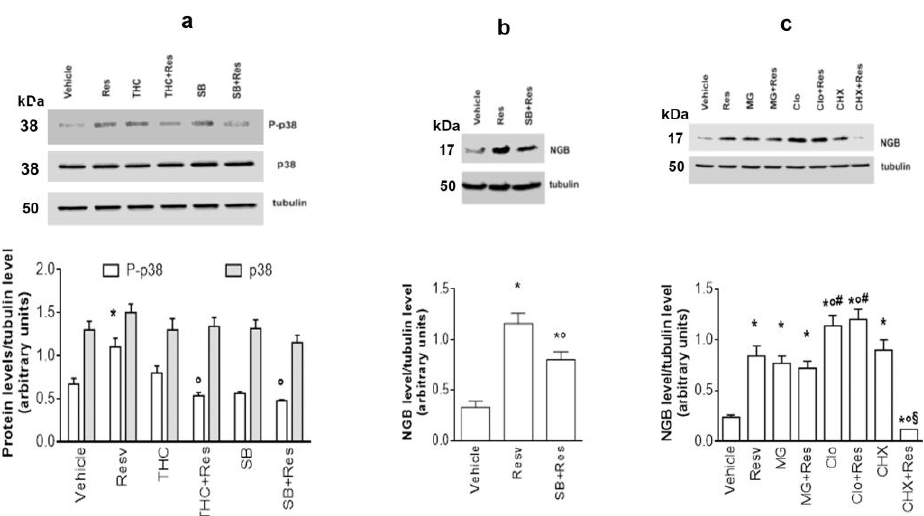
Figure 3. Signaling pathways involved in Res effect on NGB in SH-SY5Y cells. ( a ) Western blot analysis of phosphorylated-p38 (P-p38) and p38 levels in SH-SY5Y cells pretreated with (R,R)-THC (10 − 6 M) and SB (5 × 10 − 6 M) inhibitors 1 h before administration, for 24 h, of vehicle (DMSO 1:1000, v : v ), Res (10 − 7 M) and of the co-treatment with Res + (R,R)-THC and Res + SB at the same concentrations. Tubulin protein was used to normalize blot loading. The upper panel shows a Western blot type, and the lower panel shows the densitometric analysis of six different experiments. Data are reported as mean ± SD. p < 0.01 was calculated with Student’s t -test with respect to the vehicle (*) or with respect to Res (°). ( b ) Western blot analysis of NGB levels in SH-SY5Y cells treated with vehicle (DMSO 1:1000, v : v ) or Res (10 − 7 M) in the absence or the presence of the p38 inhibitor SB (5 × 10 ~6 M), 1 h pretreatment. Tubulin protein was used to normalize blot loading. The upper panel shows a Western blot type, and the lower panel shows the densitometric analysis of at least three different experiments. Data are reported as mean ± SD. p < 0.01 was calculated with Student’s t -test with respect to the vehicle (*) and Res (°). ( c ) Western blot analysis of NGB levels in SH-SY5Y cells treated for 4 h with vehicle (DMSO 1:1000, v : v ), Res (10 − 7 M), MG (10 − 6 M), Clo (10 − 5 M) and CHX (10 − 5 M) or treated with Res + MG, Res + Clo, and Res + CHX at the same concentrations. Tubulin protein was used to normalize blot loading. The upper panel shows a Western blot type, and the lower panel shows the densitometric analysis of at least three different experiments. Data are reported as mean ± SD. p < 0.01 was calculated with Student’s t -test with respect to vehicle (*), Res (°), MG (#), or CHX (§).